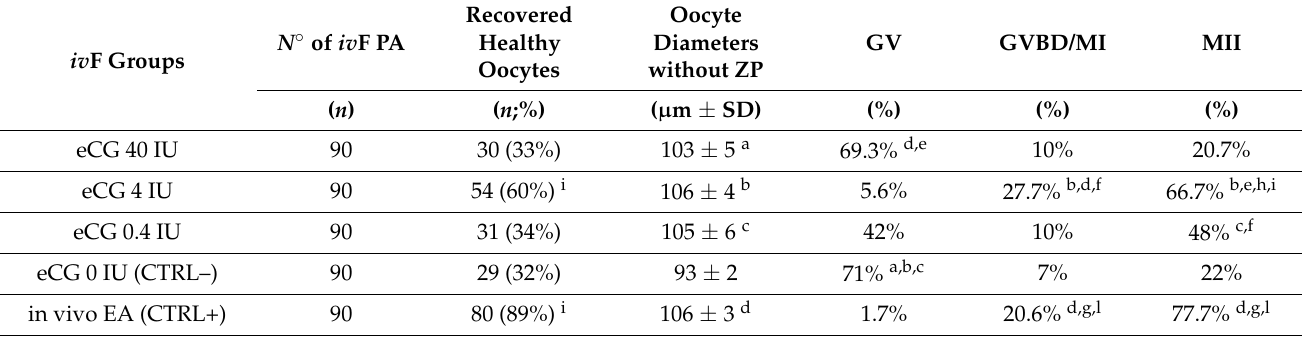
Table 2. eCG dose-effect on oocyte growth and meiotic competence.